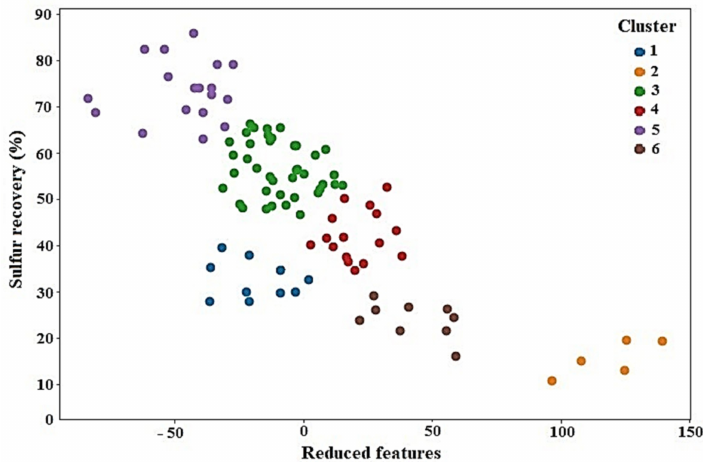
Figure 10. K-means clustering (K = 6) applied to froth feature dataset in order to group the sulfur removal